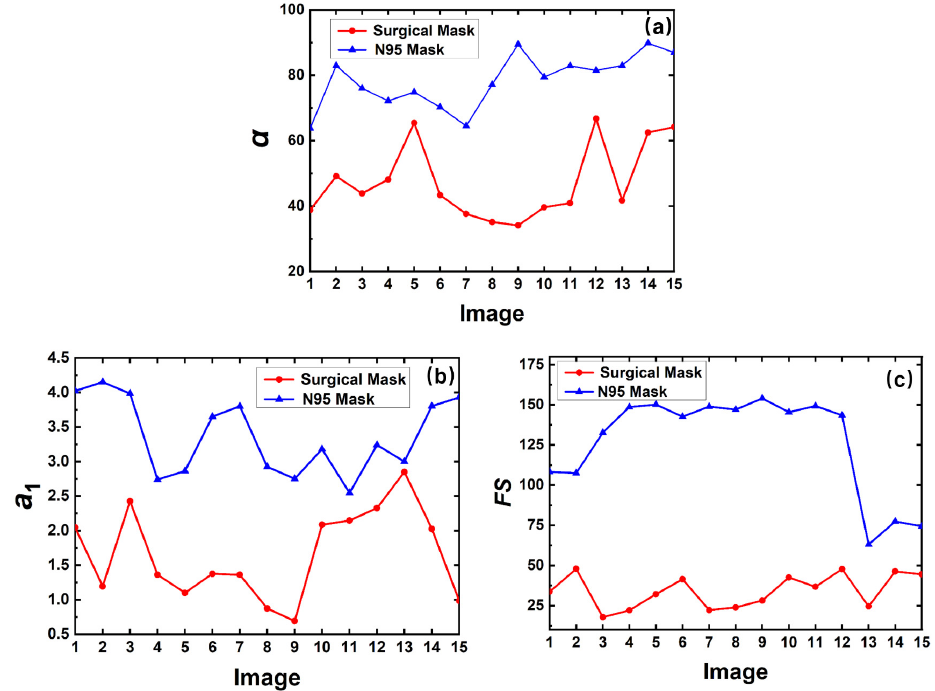
Figure 11. Feature values to identify the mask types captured from 15 images: ( a ) the α value, ( b ) the a 1 value, and ( c ) the FS value of two curve types.